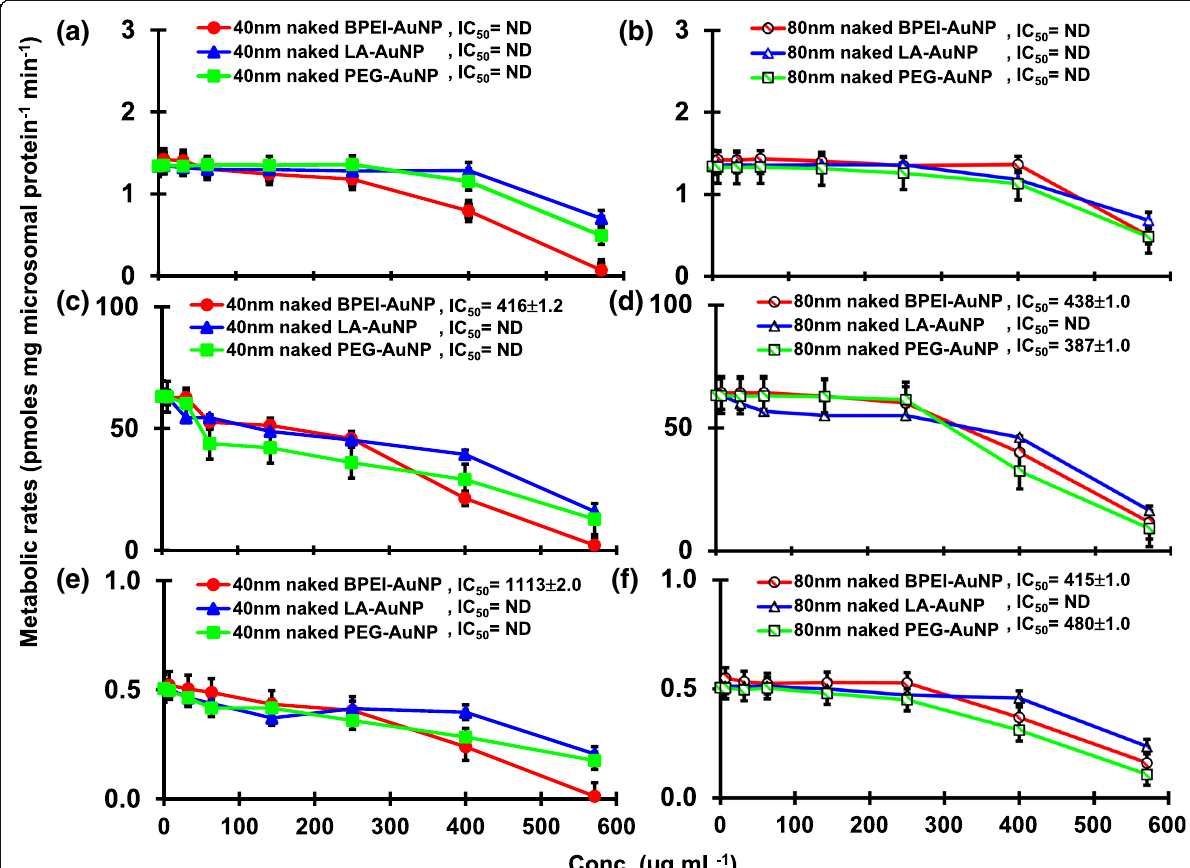
Fig. 3 Inhibitory effect of naked (no PC) AuNP on the production of 2 β -OH TST ( a , b ), 6 β -OH TST ( c , d ) and 15 β -OH TST ( e , f ) in pHLM. Data represent mean ± S.D. ( n =3). IC 50 , half maximal inhibitory conc.; pHLM , pooled human liver microsomes; ND , not determined by fitting a Hill equation with variable slope to the observed data using GraphPad Prism®; PC , human plasma protein; BPEI , branched polyethylenimine; LA , lipoic acid; PEG, polyethylene glycol; Conc, concentration; 2 β -OH TST, 2 β -hydroxytestosterone; 6 β -OH TST, 6 β -hydroxytestosterone; 15 β -OH TST, 15 β -